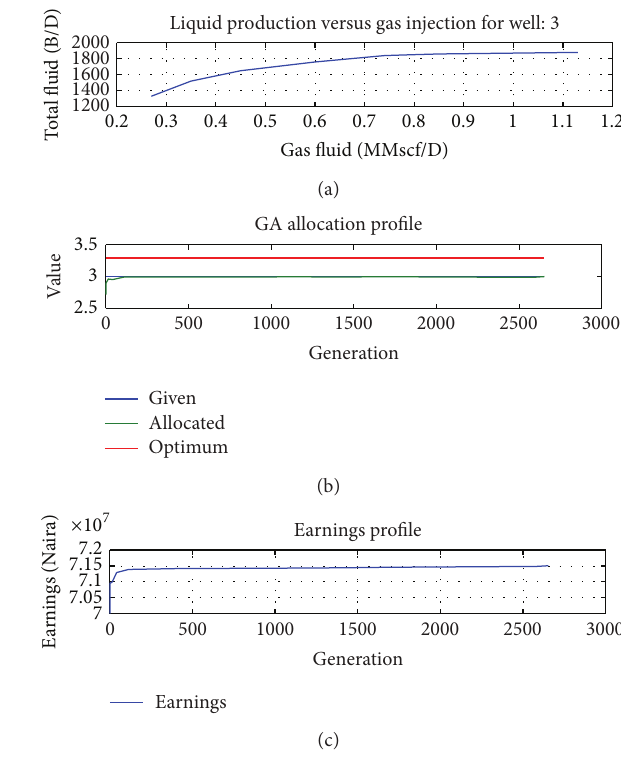
Figure 10: Well 3’s allocation profile, wells 1–3 GA allocation profile, and earnings (Naira) in a limited scenario.